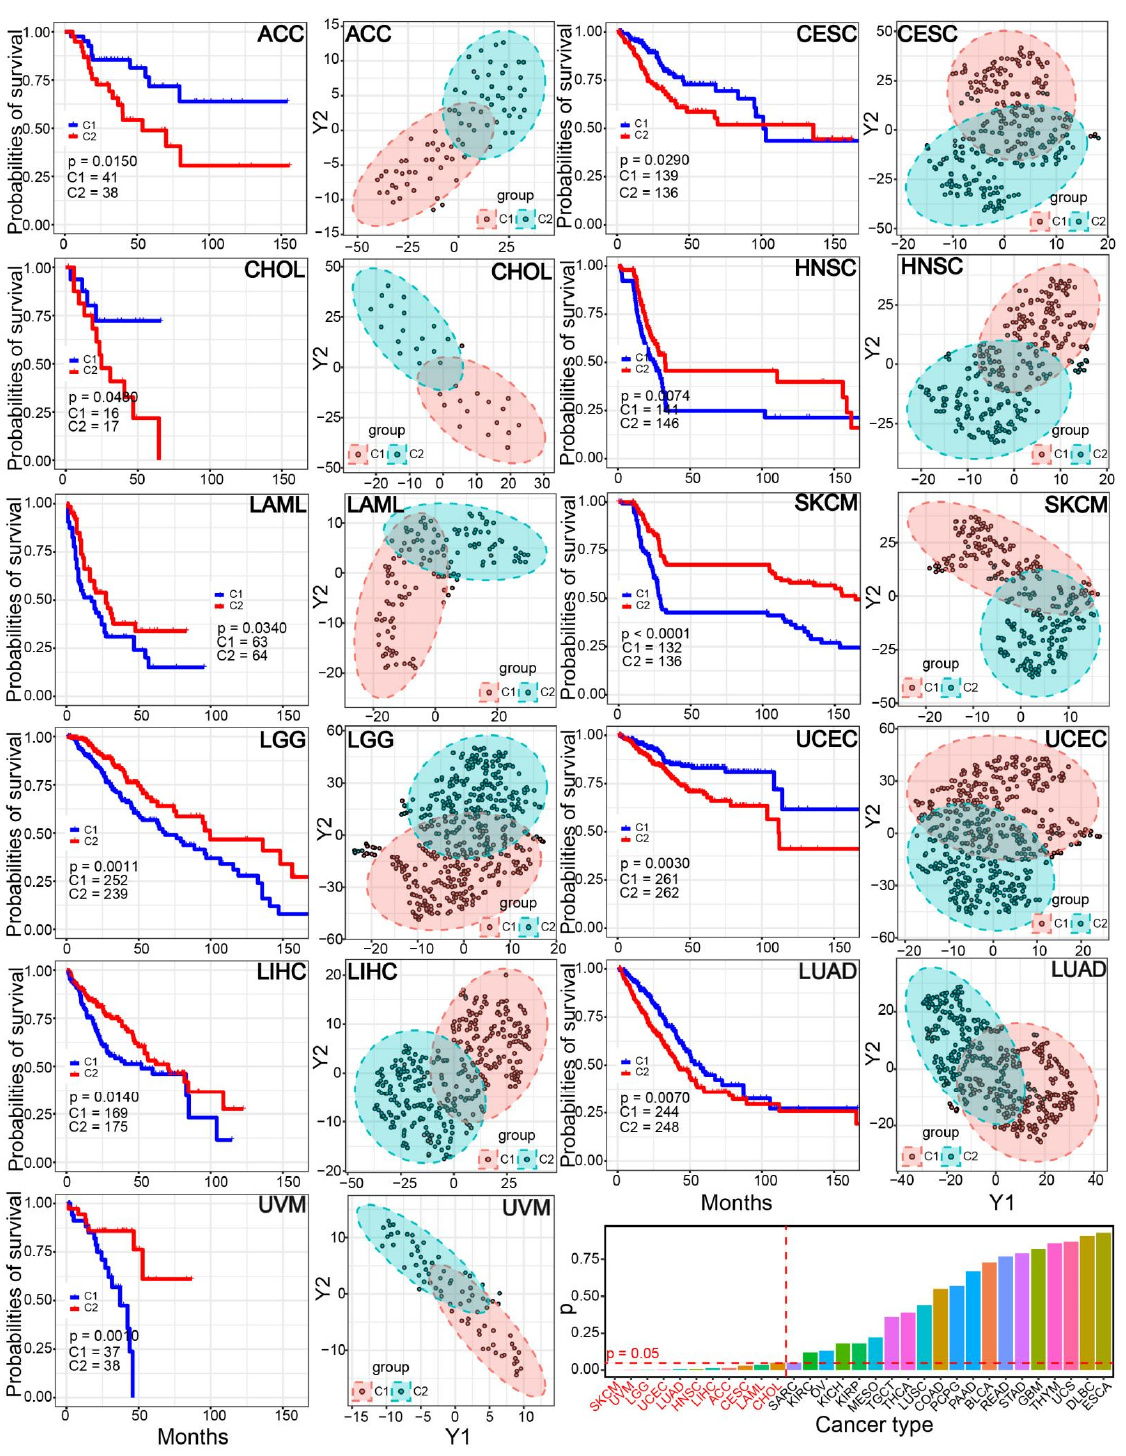
Figure 7. A pan-cancer analysis shows the two relatively independent clusters and potential prog- nostic values in 11 cancer types. The p values of survival analysis are also presented, and 11 cancers are